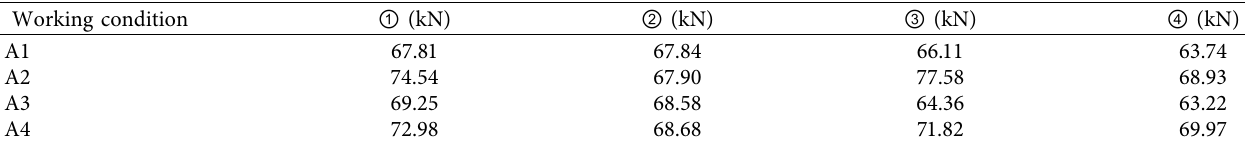
Table 7: Maximum dynamic tension of each subconductor.